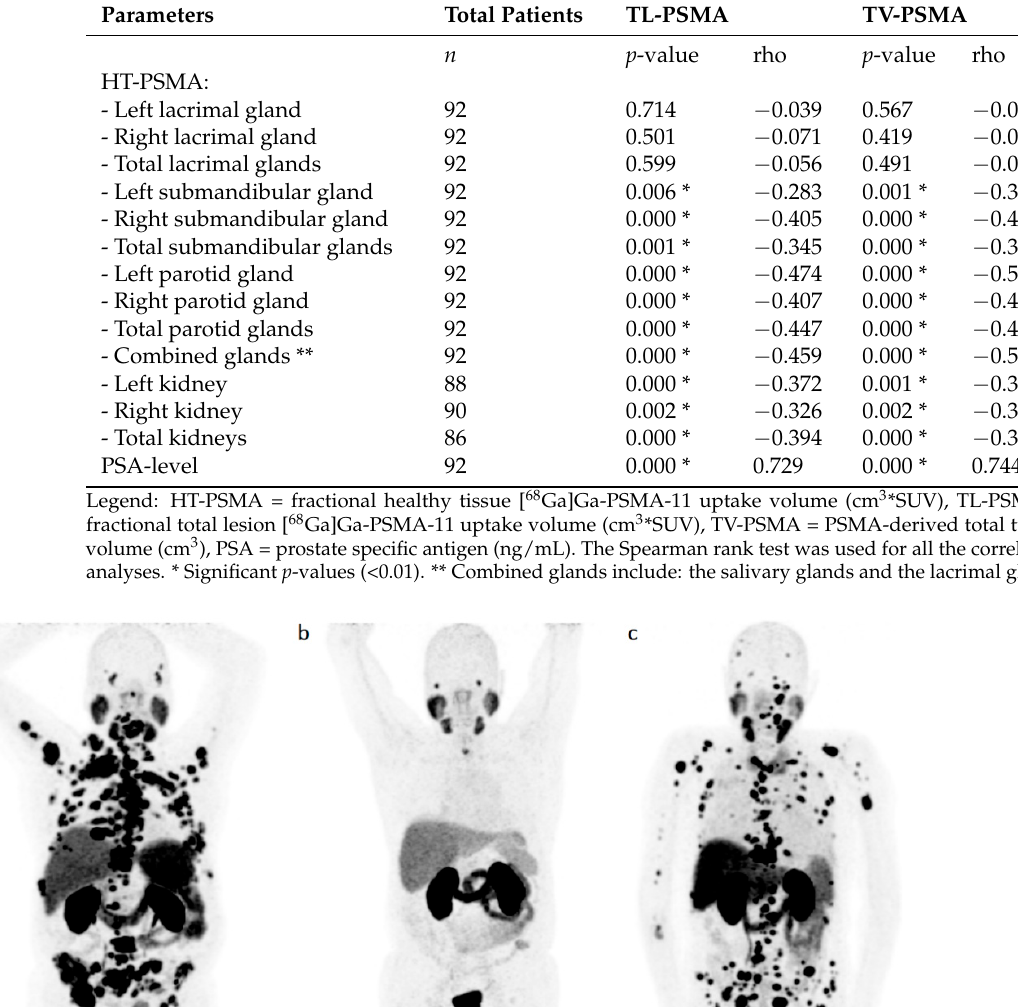
Table 2. Correlation outcomes of HT-PSMA and PSA.